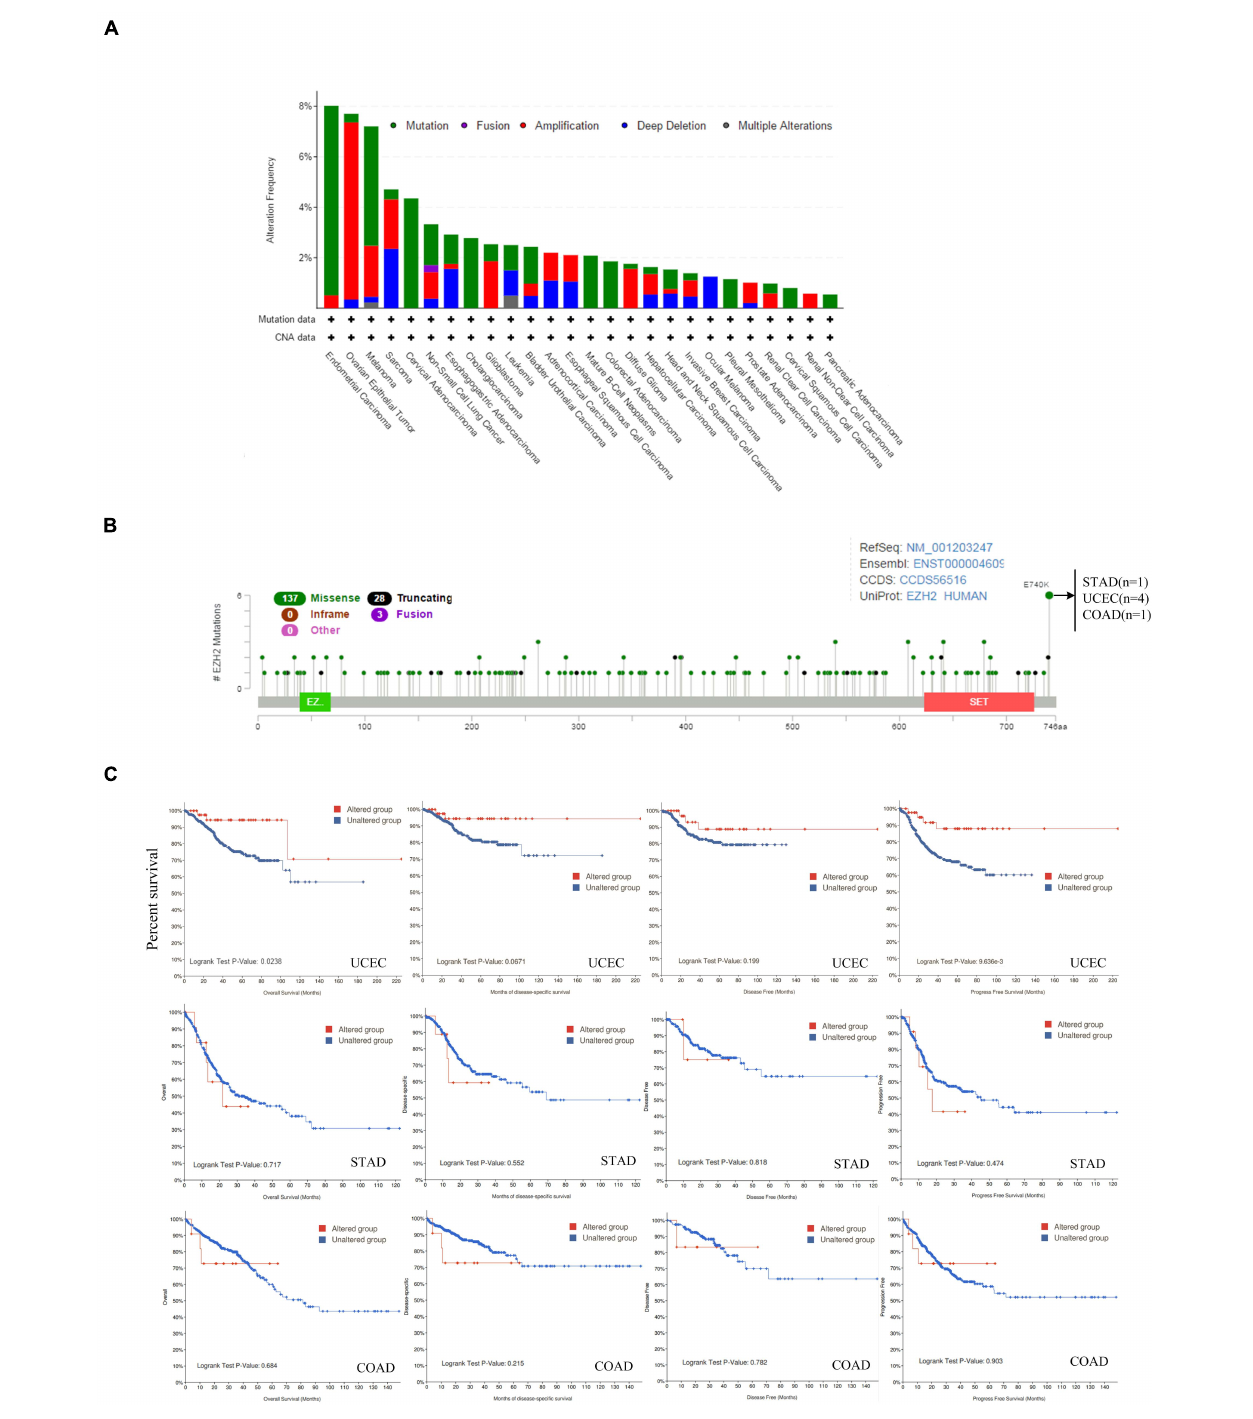
FIGURE 4 | Mutation feature of EZH2 in different tumors of TCGA. The alteration frequency with mutation type (A) and mutation site (B) are displayed. (C) The potential correlation between mutation status and overall, disease-specific, disease-free, and progression-free survival of UCEC, STAD, and COAD was investigated.